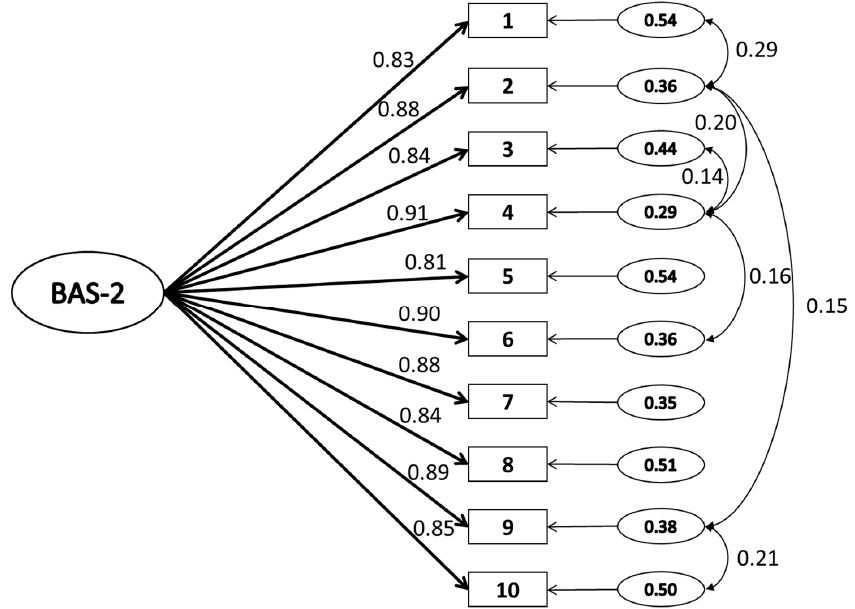
Figure 1. Path diagram and estimates for the one-dimensional model of Body Appreciation Scale-2 (BAS-2-LT) scores from the second split-half adolescent subsample ( n = 706). Note: The large oval is the latent variable, with the rectangles representing measured variables, and the small circles with numbers representing the residual variables (variances). The standardized path factor loadings are presented (all p < 0.001).